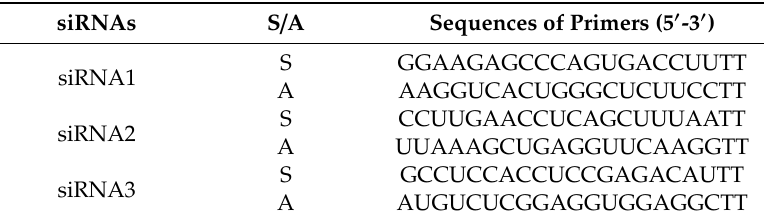
Table 2. Primer sequences of siRNAs.